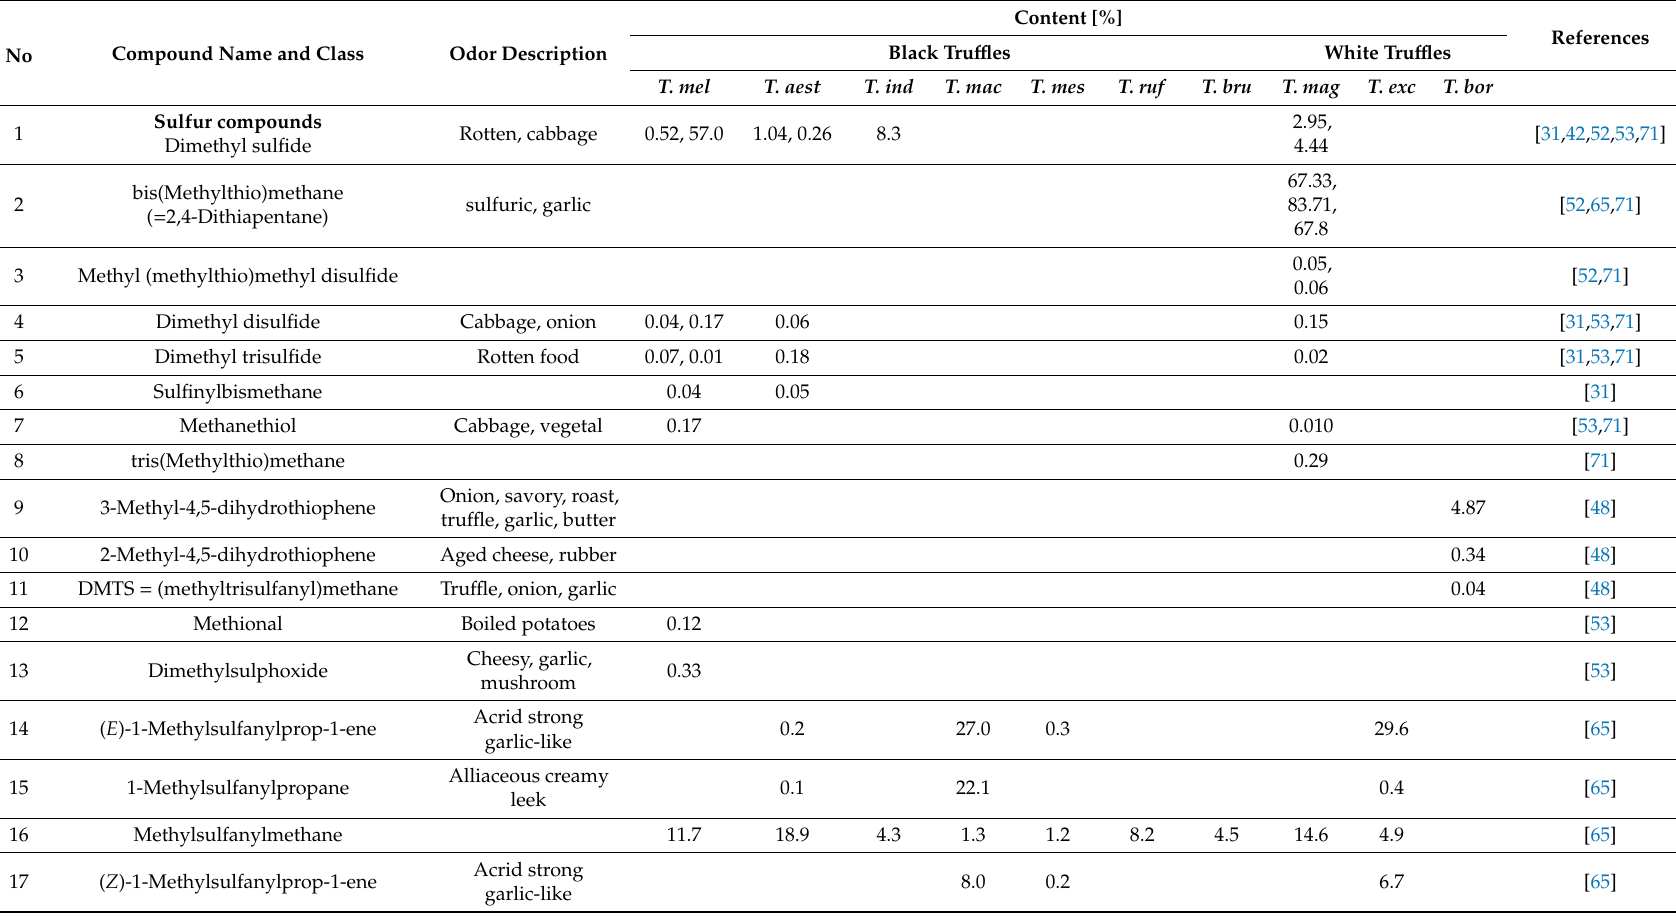
Table 1. Volatile organic components (VOCs) identified in di ff erent types of black and white tru ffl es and their relative percentages of area according to